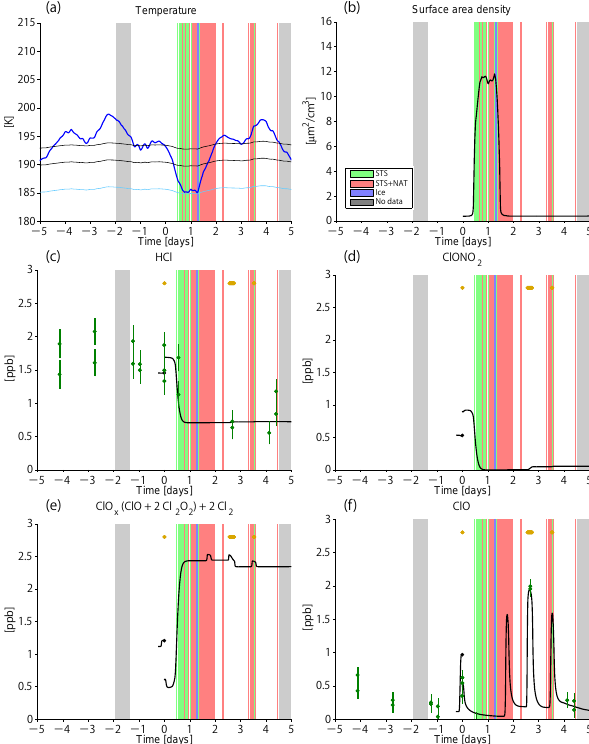
Figure 8. Results of the ATLAS chemistry model along the trajec- tories and comparison with measurements by MLS for the trajec- tory case no. 03 starting at 07:58:21UT on 23 December 2009 at an altitude of 22.07km. (a) Temperature (as in Figs. 5–7), (b) PSC sur- face area density, (c) HCl mixing ratio, (d) ClONO 2 mixing ratio, (e) ClO x (ClO + 2 × Cl 2 O 2 ) + 2 × Cl 2 mixing ratio, (f) ClO mixing ratio. Matched MLS measurements of HCl and ClO are shown in panels (c) and (f) (green dots with error bars). Black line in pan- els (b) – (f) show ATLAS model results. The color-coded areas show PSC occurrence measured by CALIOP along the trajectories, with the color code shown in lower left of panel (b) .